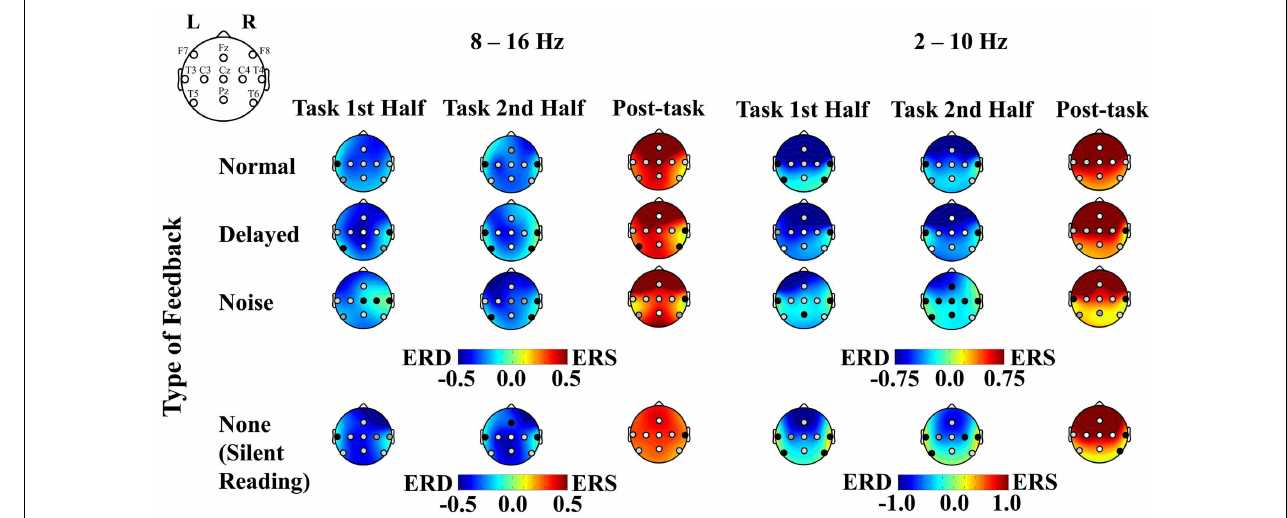
between the second activation and the post-task intervals.The p -value for each recording site is shown in white, light gray, gray, and black for p < 0.001, p < 0.05, p < 0.1, and p > 0.1, respectively.The results for the 8–16 and 2–10Hz range are shown on the left and right sides,